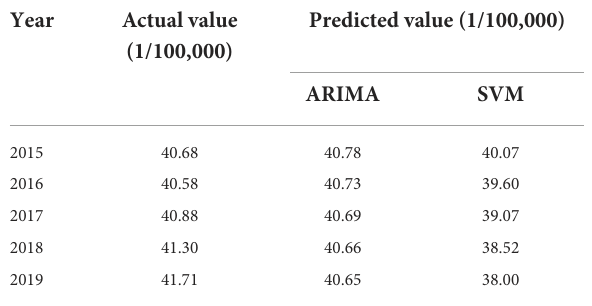
TABLE 3 Comparison of actual and predicted incidence rates between ARIMA and SVM models.